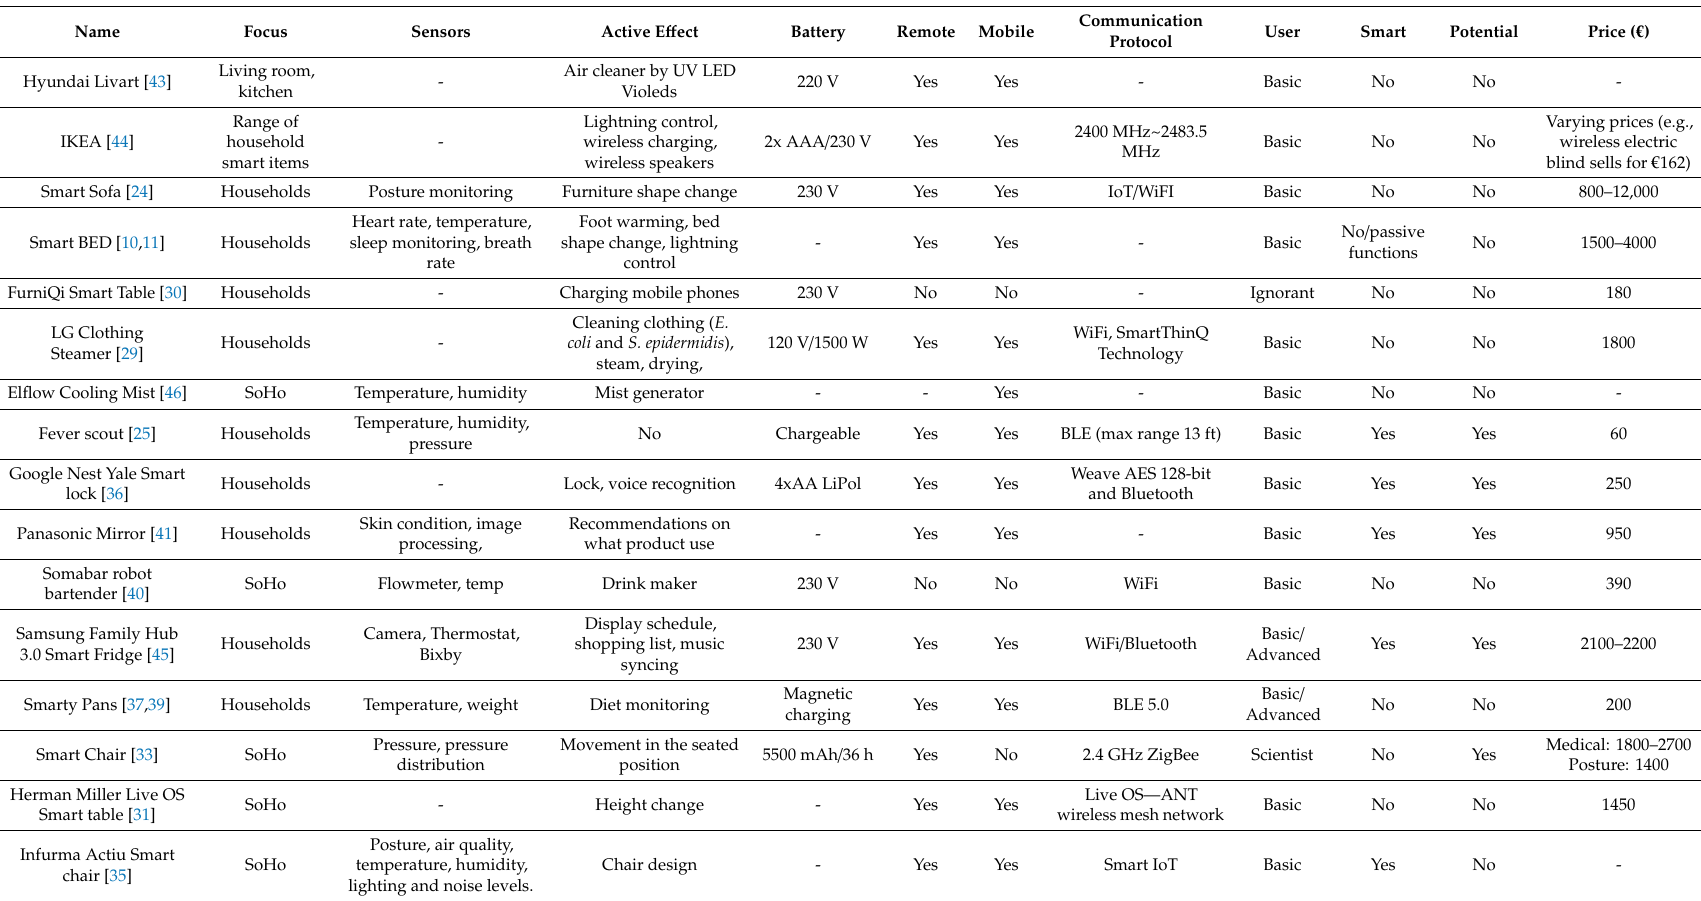
Table 4. Selected Smart Furniture solutions on the